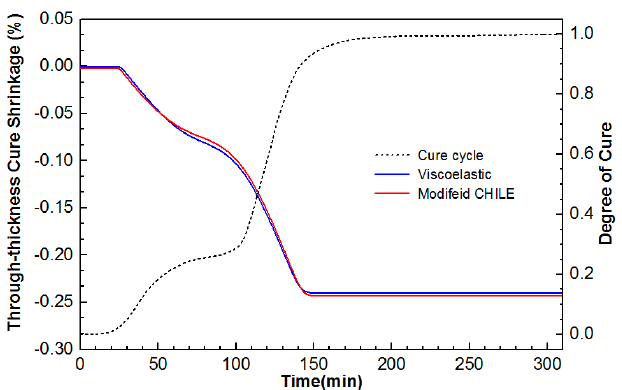
Figure 8. Comparison of cure shrinkage in the through-thickness orientation from the modified CHILE and viscoelastic models.